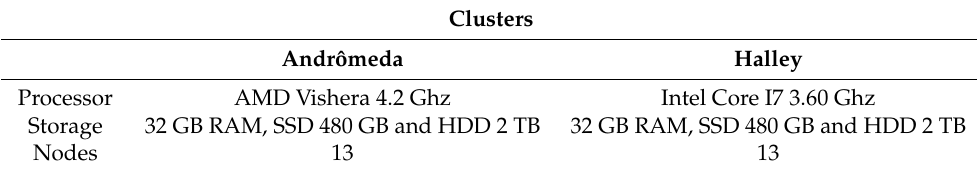
Table 5. Configurations of